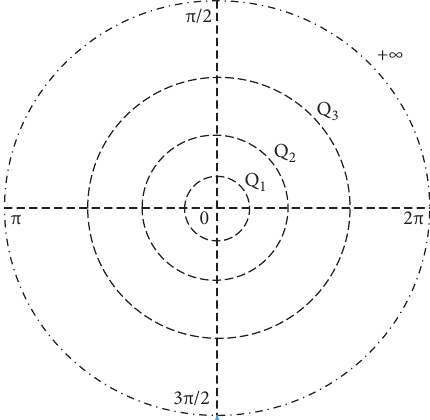
Figure 2: Joint quantization interval of amplitude and phase.